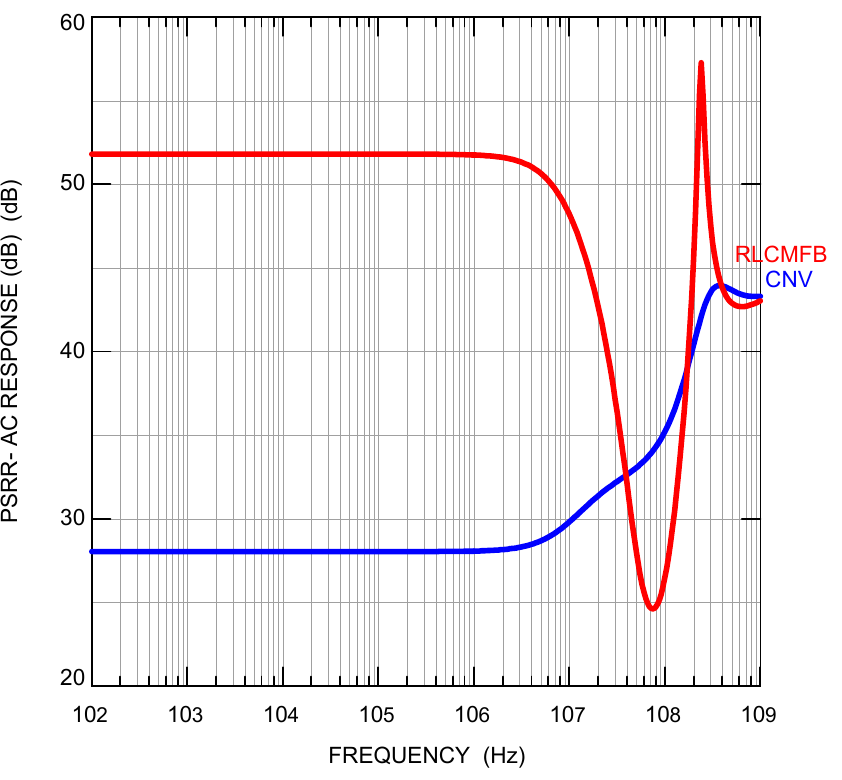
Figure 8. Positive PSRR of circuits of Figure 3.